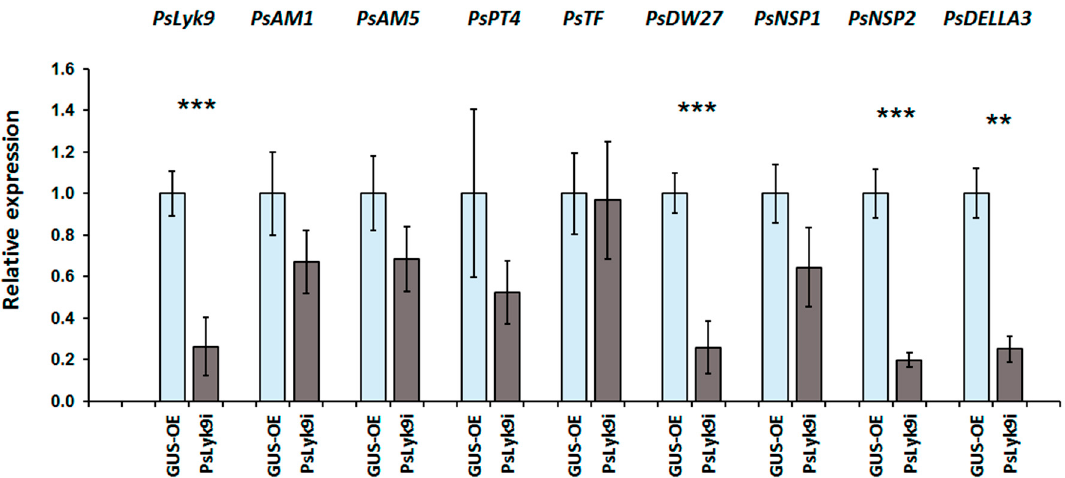
Figure 8. Reduction in gene expression level of PsDWARF27 , PsNSP1 , PsNSP2 , and PsDELLA3 in the transgenic pea roots with PsLyk9 knockdown treated with 10 − 5 M CO5 for 24 h. GUS-OE—transgenic pea plants transformed with pB7WG2D-GUS construct (control); PsLyk9i —transgenic pea plants transformed with the pK7GWIWG2D- PsLyk9i construct. Error bars indicate the SEM of seven-ten biological repeats. Asterisks indicate statistically significant differences compared with control (GUS-overexpressing plants (GUS-OE)): *** p < 0.001, ** p < 0.01.